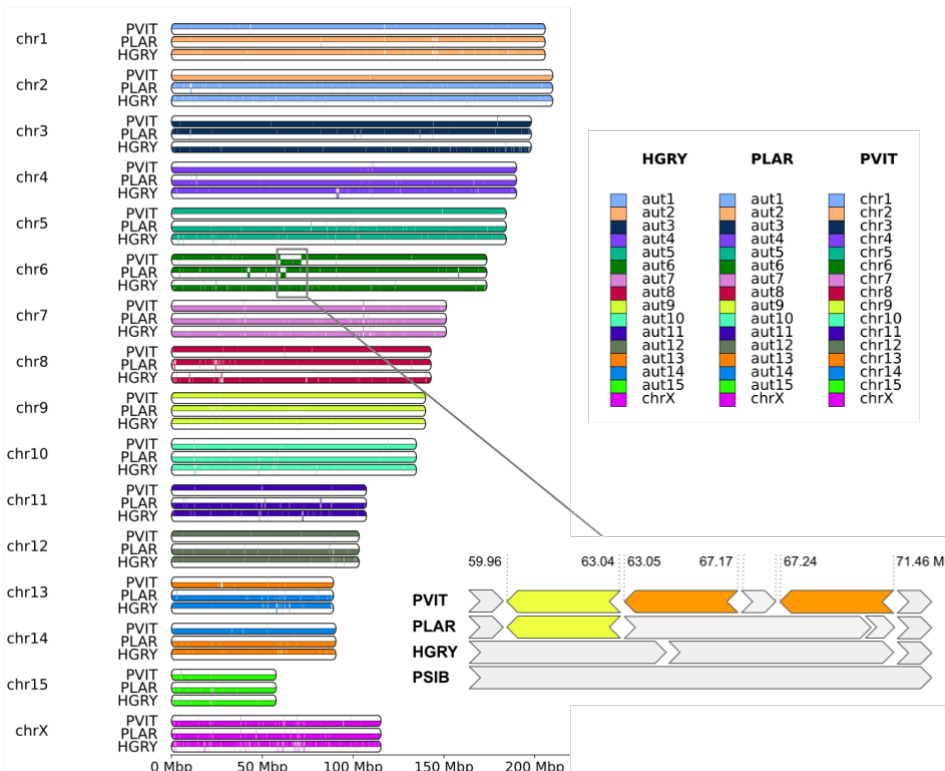
Figure 2. The synteny blocks between four pinniped species: PSIB was chosen as a reference and HGRY, PLAR, and PVIT were designated as the query species. Each chromosome was split into bottom and top parts: synteny blocks were drawn on the top part if it had the same orientation in both the reference (PSIB) and query species, and in the bottom part if the orientation was different. Chr 6 was enlarged, to emphasize the presence of three megabase-scale inversions. The yellow color on the enlarged pane highlights the single inversion common for PVIT and PLAR, and the orange color indicates the two inversions unique to PVIT. HGRY chr6 was reverse complemented in the small pane, and labeled with an asterisk on the small pane to avoid